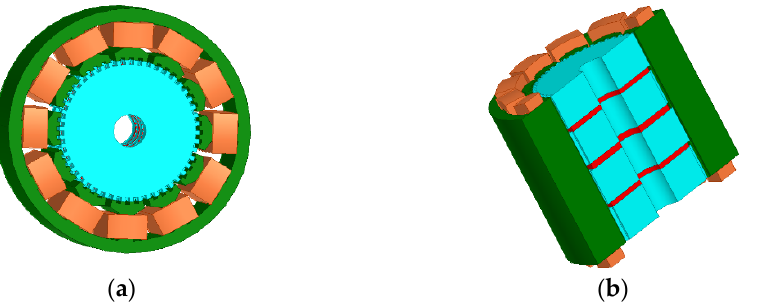
Table 2. The test motor parameters.